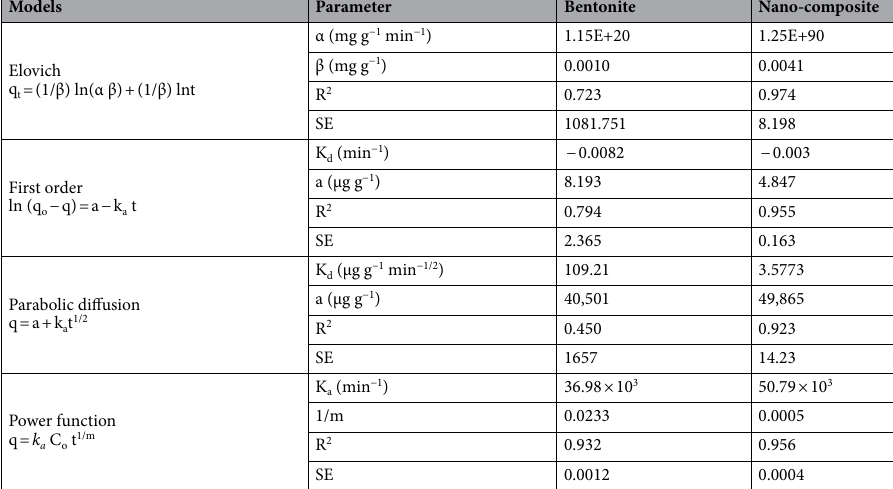
Table 1. Kinetics model constants and determination coefficients and standard error of estimate for Pb(II) adsorption by bentonite and composite sorbents. q or q t = Pb adsorbed (mg kg −1 ) at time t , q o = Pb adsorbed (mg kg −1 ) at equilibrium, k a = apparent sorption rate coefficient, α = the initial adsorption rate (mg g −1 min −1 ), β = a constant related to the extent of surface coverage (mg g −1 ), a = a constant; k d = apparent diffusion rate coefficient, q = adsorbed Pb (mg kg −1 ), C ο = initial Pb concentration (mg L −1 ), t = reaction time (min), k a = sorption rate coefficient (min −1 ), and 1/ m = constant. R 2 = determination coefficient, SE standard error of estimate.